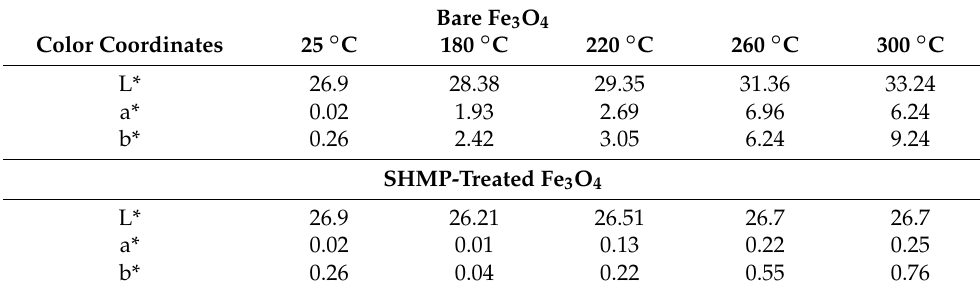
Figure 12. Photograph of the dispersion test of the paint system through the Hegman gauge for bare Fe 3 O 4 and treated Fe 3 O 4 at different concentrations. Table 5. Colorimetric parameters of bare Fe 3 O 4 and SHMP-treated Fe 3 O 4 at different temperatures.